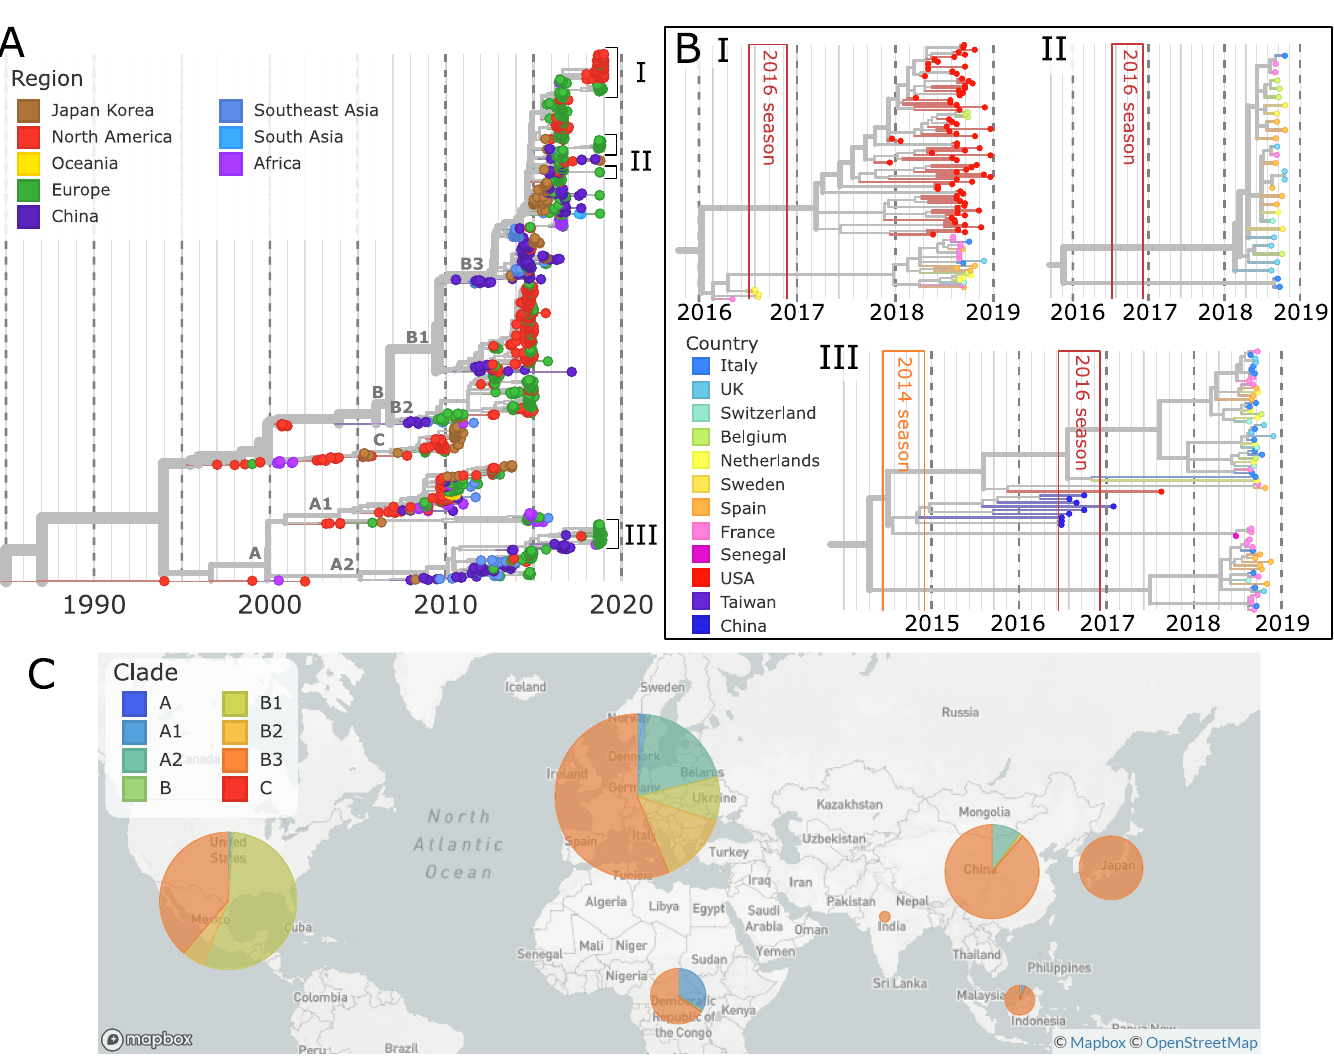
Fig 1. Time-scaled phylogeny of Enterovirus D68. A) A time-scaled phylogeny of VP1 segments, colored by region, is shown top-left. B) Key clusters (I, II, III), the largest from the 2018 season, are highlighted, colored by country. To display these clusters at a high resolution, the whole genome phylogenies are used. The 2014 and 2016 EV-D68 seasons are shown in orange and red boxes. C) A map shows the distribution of subclades by region from 2014–2018. Map from Mapbox and OpenStreetMap.